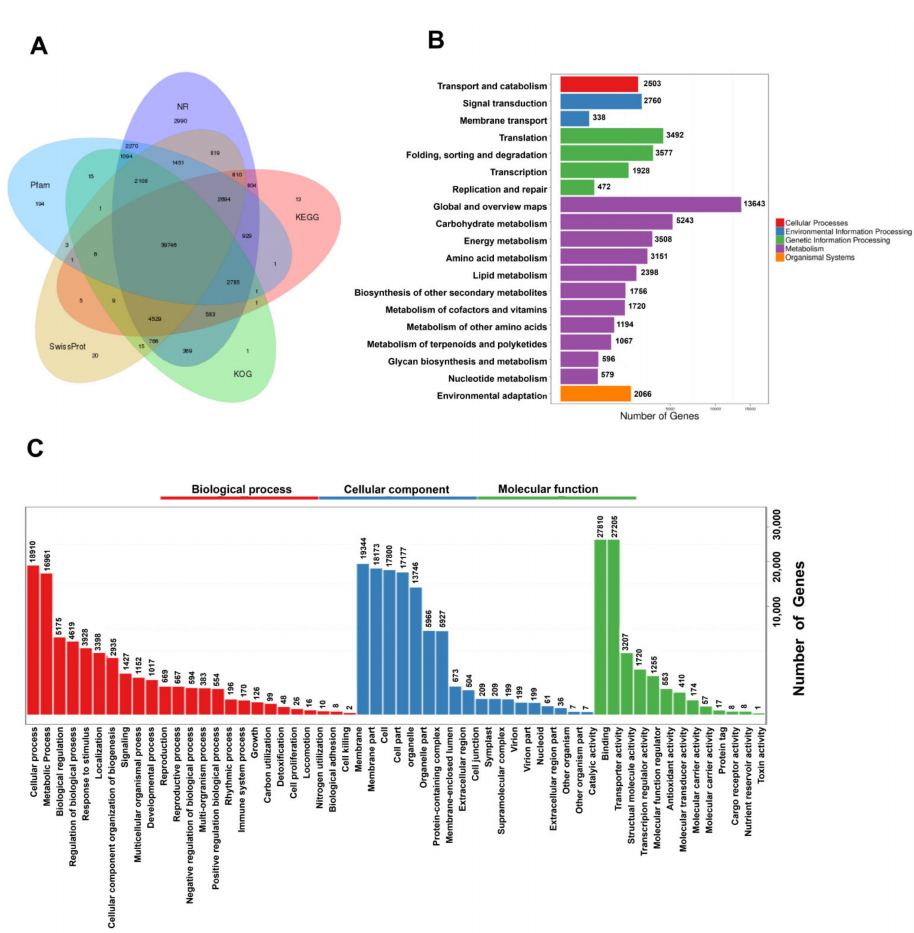
Figure 2. Functional annotation and classification of assembled A. argyi unigenes. ( A ) Annotation details arranged in a Venn diagram. ( B ) KEGG pathway classifications for putative proteins. ( C ) GO classifications for A. argyi unigenes, including biological process (BP), cellular component (CC), and molecular function (MF)